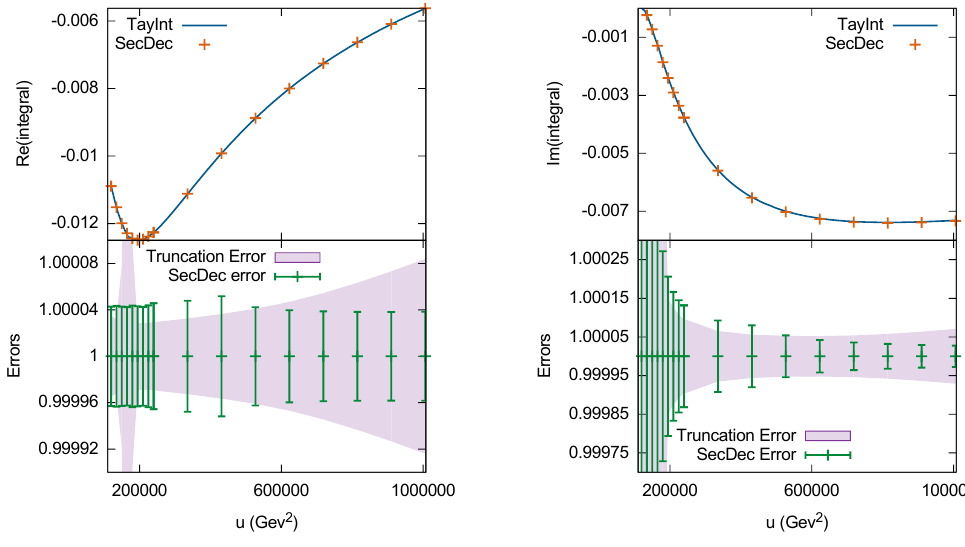
Figure 18 . The I10 Integral calculated at O ( (cid:15) 2 ) with a fourth-order series expansion. The scale u m 1 and m 1 = 173 GeV. The lower plots show the relative is over the 4 m 2 threshold, with m 2 = 1 p 1 2 TayInt and SecDec errors,